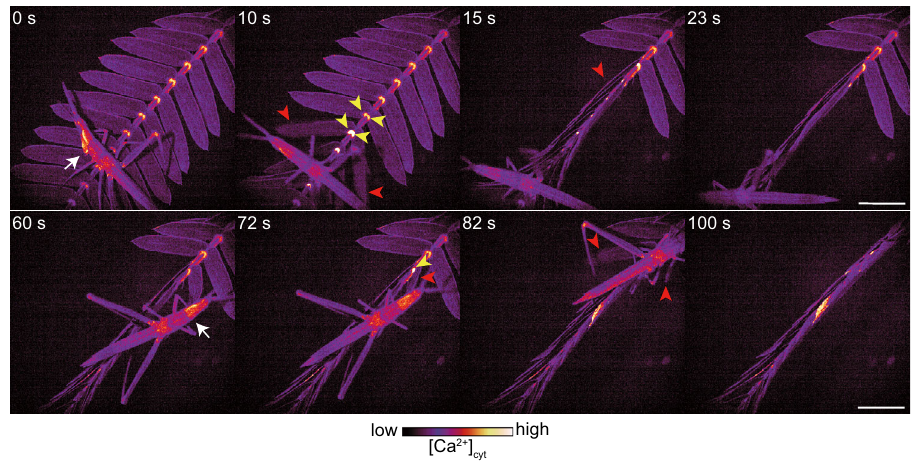
Fig. 4| Insectattack induces[Ca 2+ ] cyt increasesand lea fl et movements. Feeding onalea fl etbyagrasshopper(whitearrows,0and60s)caused[Ca 2+ ] cyt increasesin